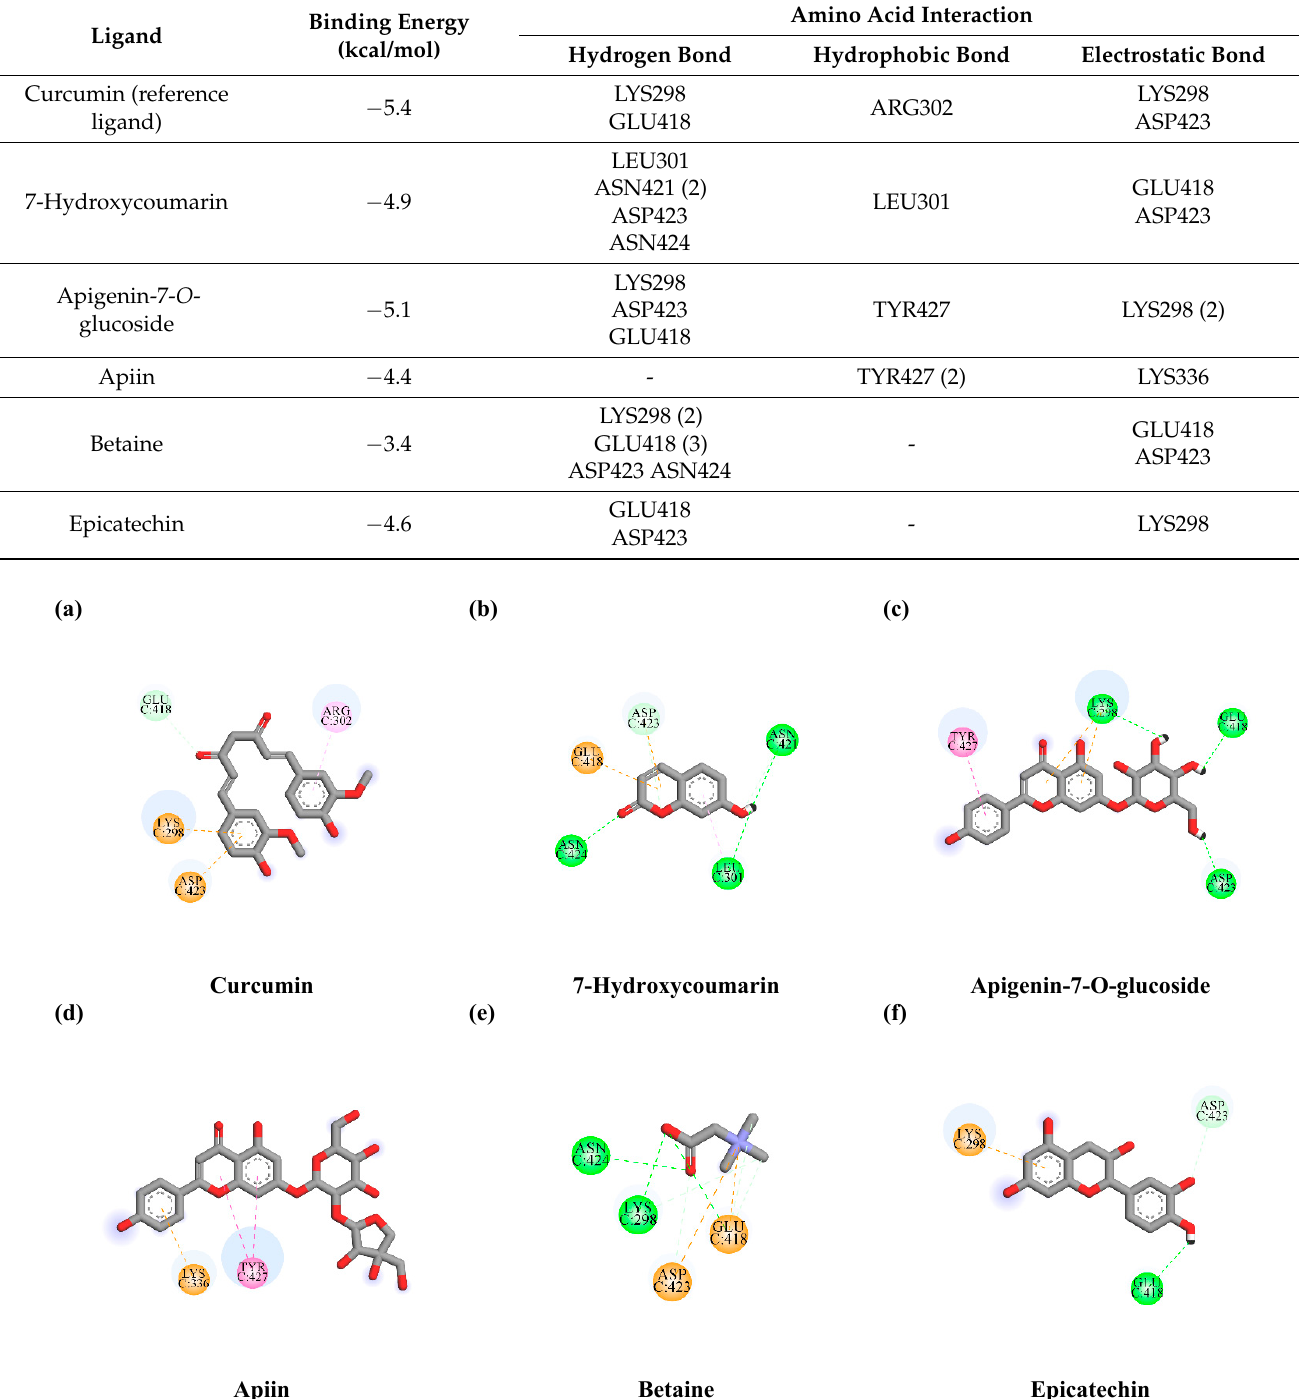
Table 3. Molecular docking results of candidate ligands at the binding site of PINK1 (PDB ID: 6EQI).